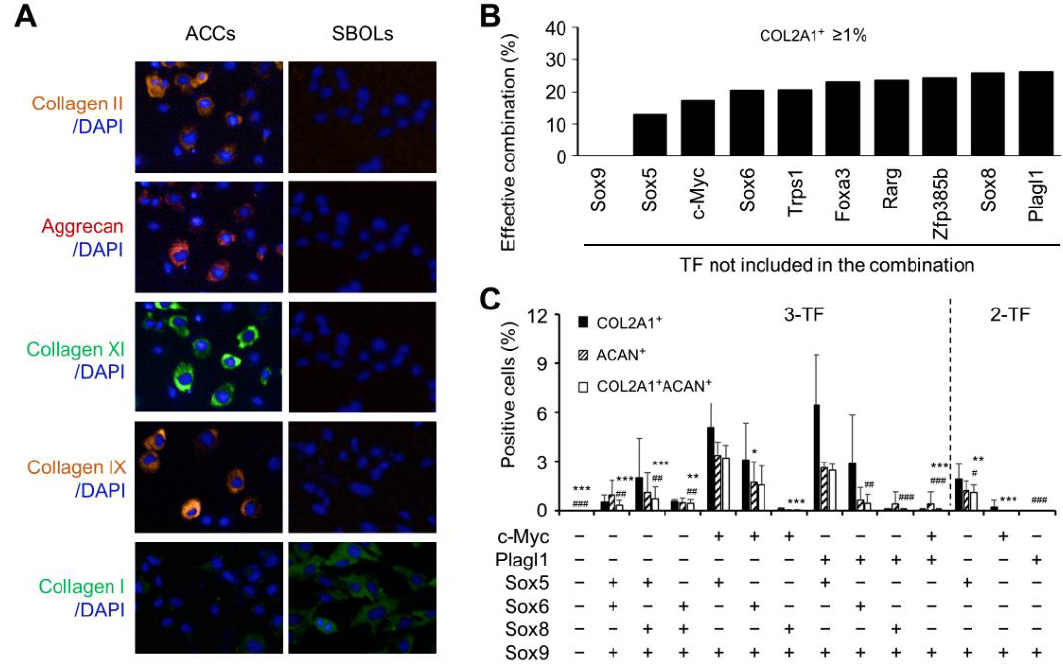
Figure 3. Ectopic expression of Sox9 and Sox5 together with c-Myc or Plagl1 directly converts SBOs into ACC-like cells. SBOLs were transduced with transcription-expressing lentiviruses at an MOI of 100 twice with 8 µg/mL polybrene. After 14 d of culture, cells were fixed for immunofluorescence analyses. ( A ) Immunofluorescence staining of collagen and aggrecan in primary ACCs and SBOLs. Magnification: 200×. ( B ) Transcription factors essential in the reprogramming of SBOs into ACC-like cells, which was determined based on the efficiency in inducing COL2A1 expression by all of the combinations that did not include the transcriptional factor indicated. Each one was tested in at least 20 different combinations containing 4 or 6 transcription factors. ( C ) Induction of COL2A1 + , ACAN + , and COL2A1 + ACAN + cells by Sox9-containing 2 – 3-TF combinations. Data shown in the bar graph represent mean ± SD ( n = 3 – 4). *, **, and *** indicate statistically significant difference from Sox9 + Sox5 + c-Myc. #, ##, and ### indicate statistically significant difference from Sox9 + Sox5 + Plagl1.